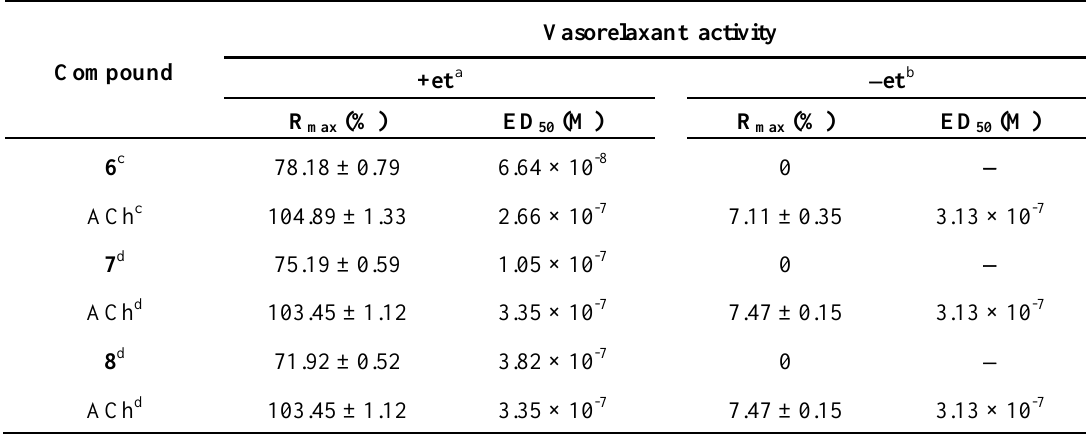
Table 2. Effect of endothelial cells on vascular effect of nicotinic acid analogs 6 - 8